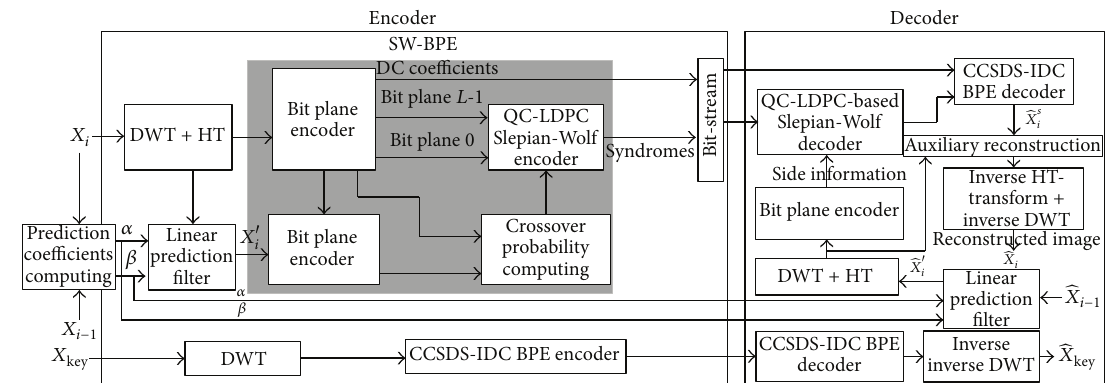
Figure 3: Proposed compression algorithm based on CCSDS-IDC merged to DSC by deep coupling way for multispectral images.